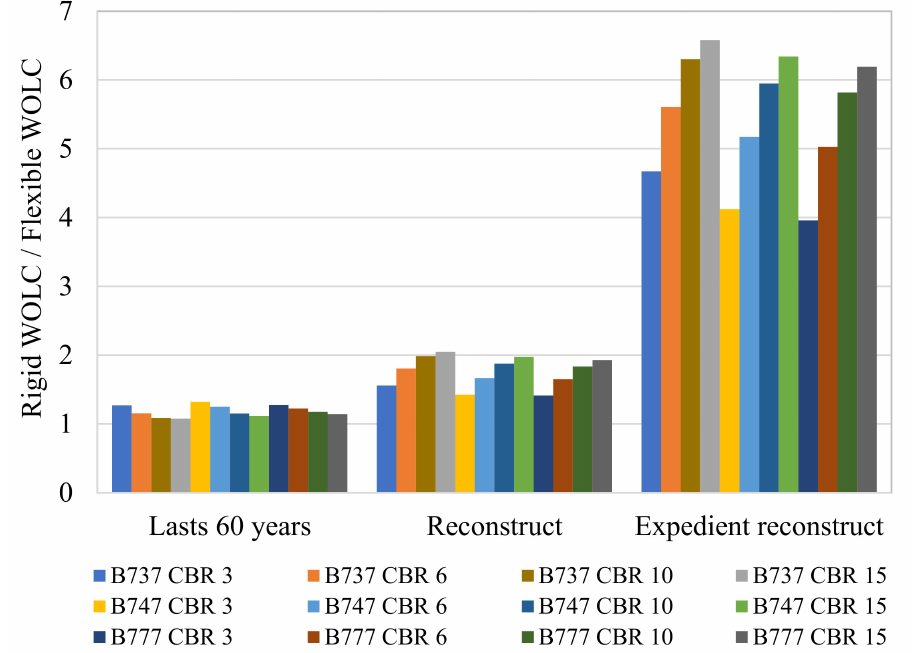
Figure 8. Effect of end-of-life assumption on rigid/flexible WOLC cost